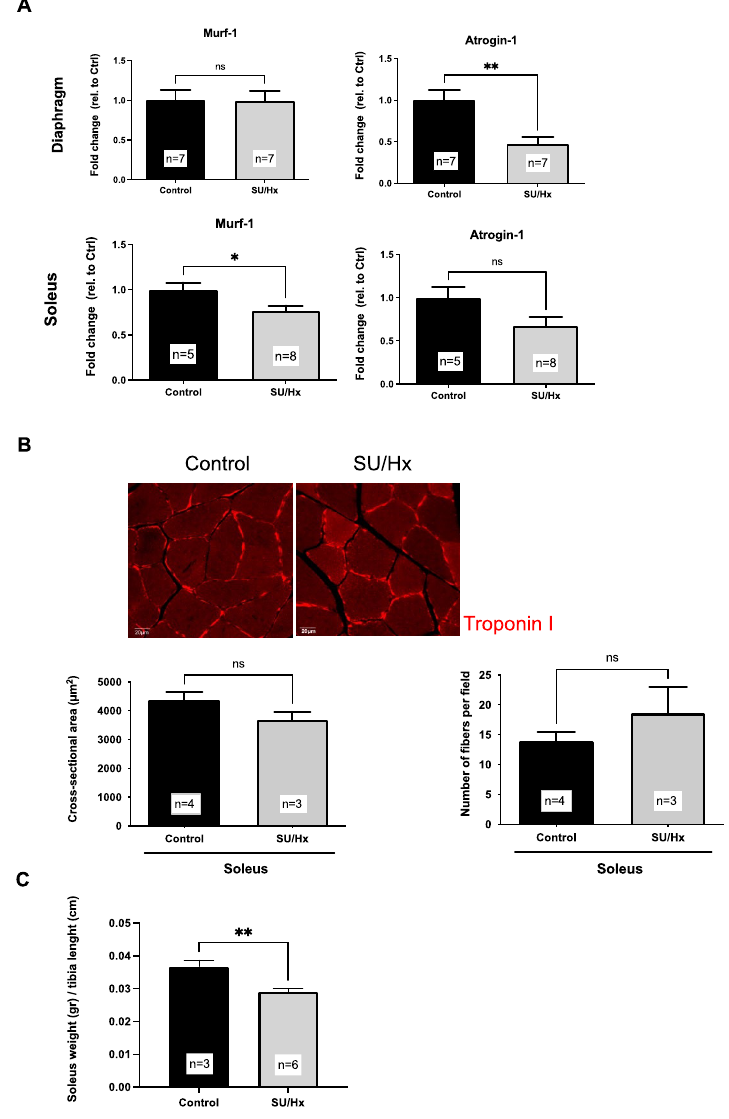
Figure 4. ( A ) No difference is seen in atrophy markers ( MuRf1 , Atrogin ) in diaphragm and soleus muscle from SU/Hx-induced PH rats when they are compared to the controls. Expression normalized to Nup 133 . ( B ) No difference is seen in average cross-sectional area and in the number of soleus muscle fibers per field for SU/Hx-induced PH rats when these are compared to those of the controls. Representative images of troponin I-stained soleus sections from SU/Hx-induced PH rats and controls. Scale bar, 20 µ m. ( C ) Decreased ratio is seen in the soleus weight-to-tibia length from SU/Hx-induced PH rats when compared to that of the controls. Values are expressed as the mean ± SEM.